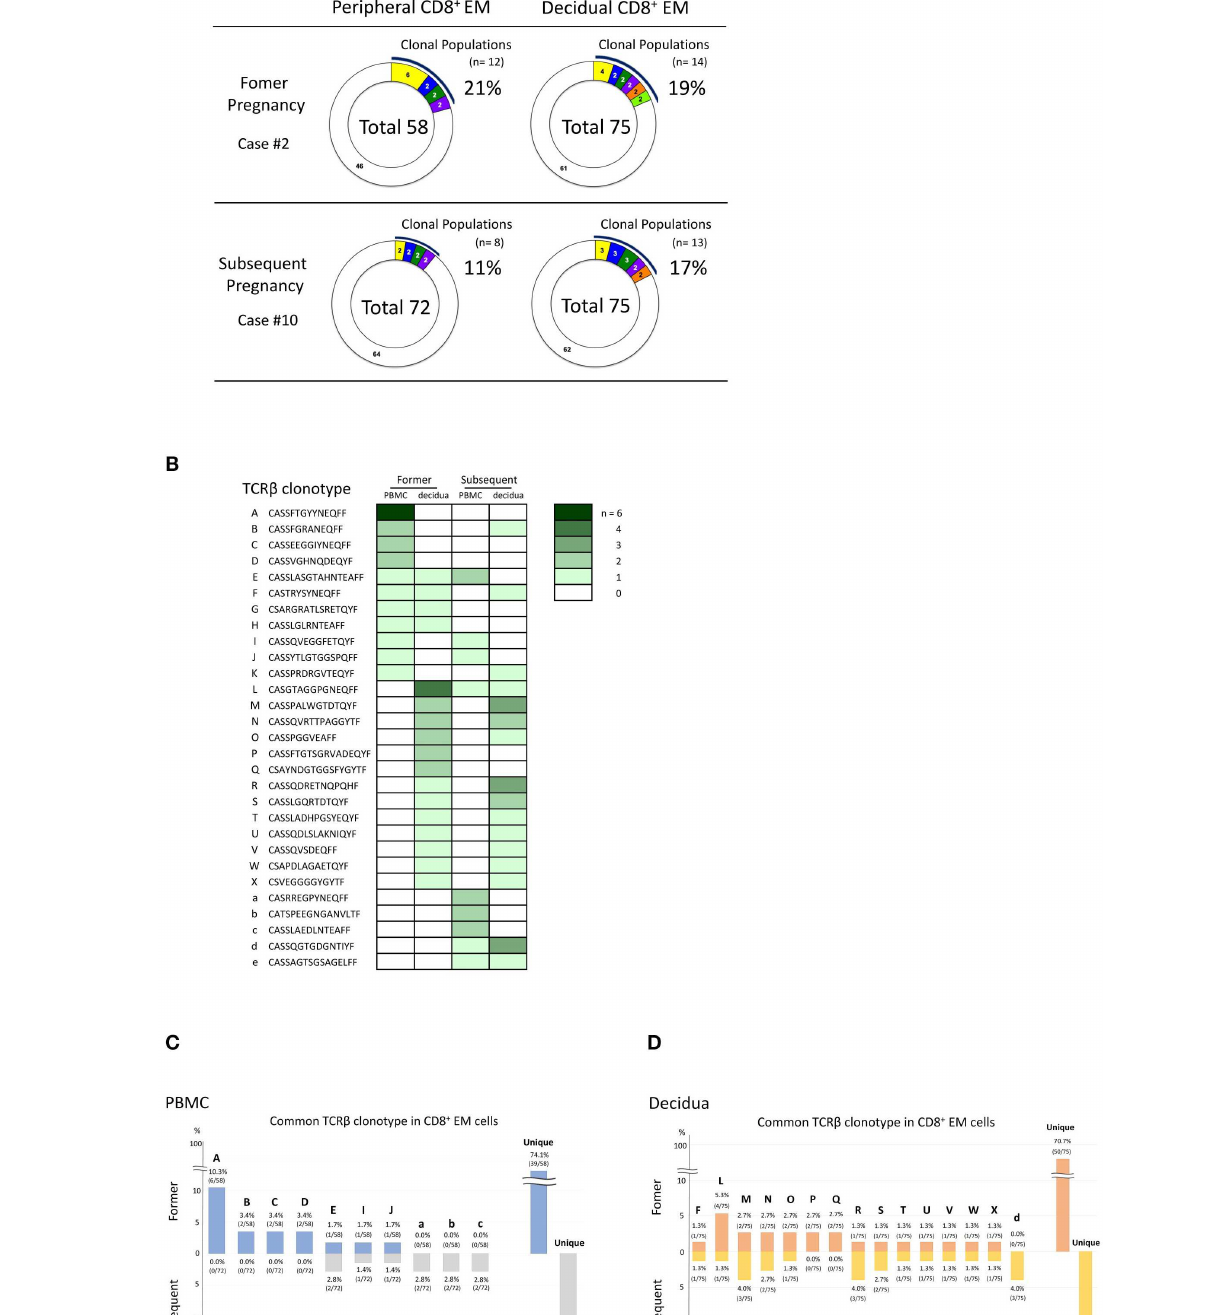
Frontiers in Immunology | www.frontiersin.org